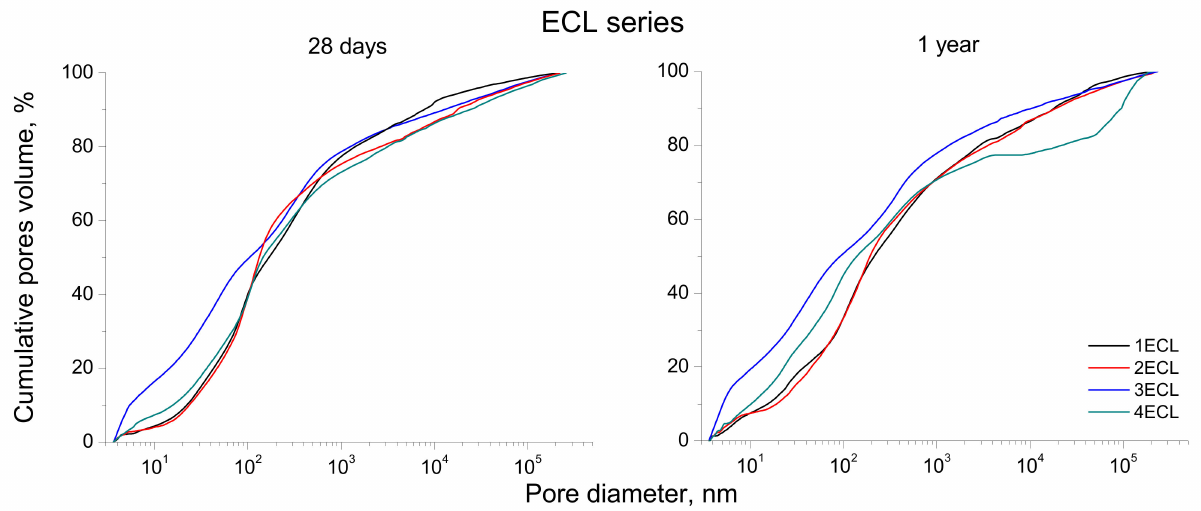
Figure 5. Cumulative volumes of pores in percentage versus pore size curves for series with expanded